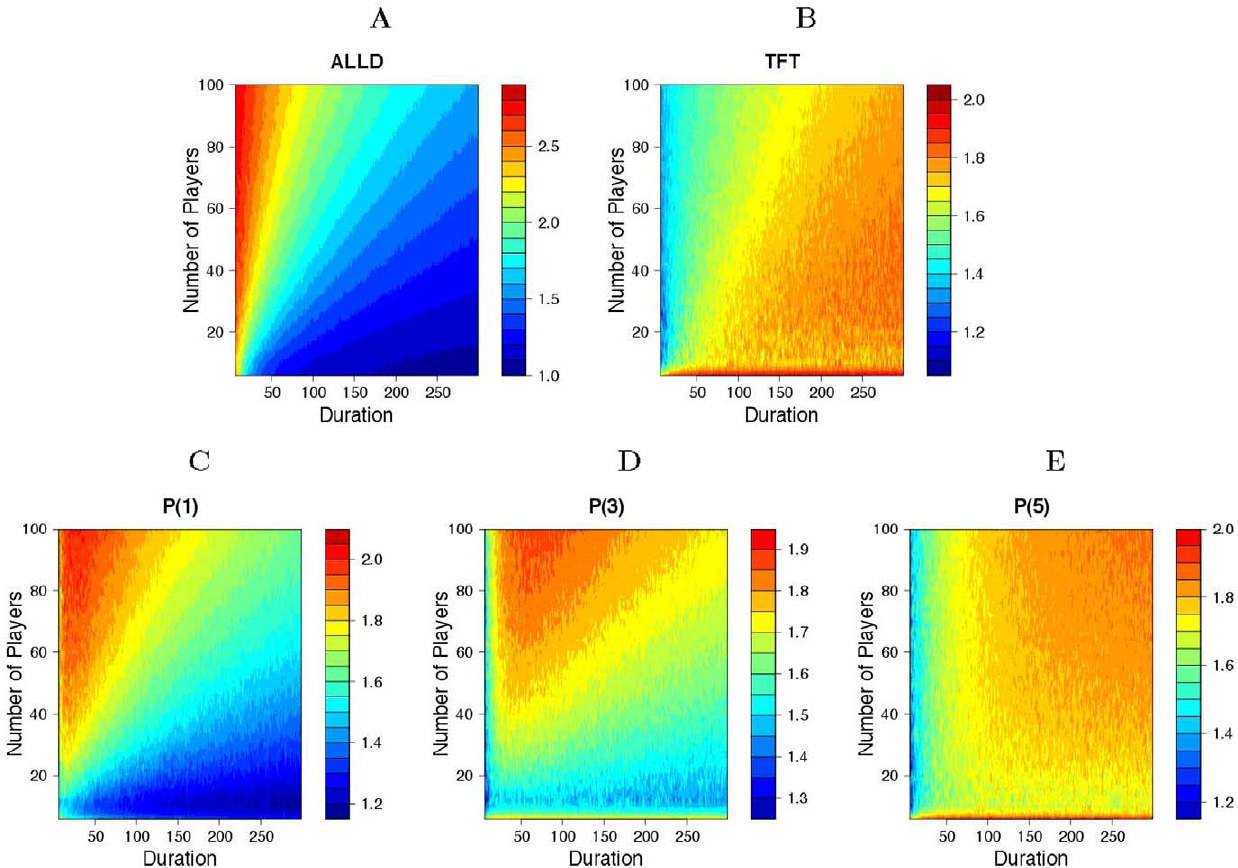
Figure 2. Performance of prejudiced and non-prejudiced strategies. Average score of different strategies as a function of the two components of the ‘‘shadow of the future’’ SF (game duration | number of players). The five ‘‘heat’’ plots illustrate the average payoff of various strategies in a population split equally between TFT and ALLD players (A and B). In simulations C–E, one single prejudiced player is added to each simulation. Each individual is given five random binary traits, and prejudiced players extrapolate based on one ( P (1) ), three ( P (3) ) or all of these traits ( P (5) ). TFT performs well when the shadow of the future is long (small population and long duration). In contrast, ALLD performs best for a short shadow of the future. Prejudiced strategies perform best for intermediate shadows of the future. Each data point on the 100 | 300 grid is an average over five hundred simulations, for a total of 15 million simulations.